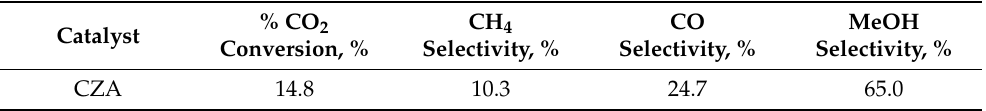
Table 5. Experimental results obtained with the CZA catalyst with feed stream composition